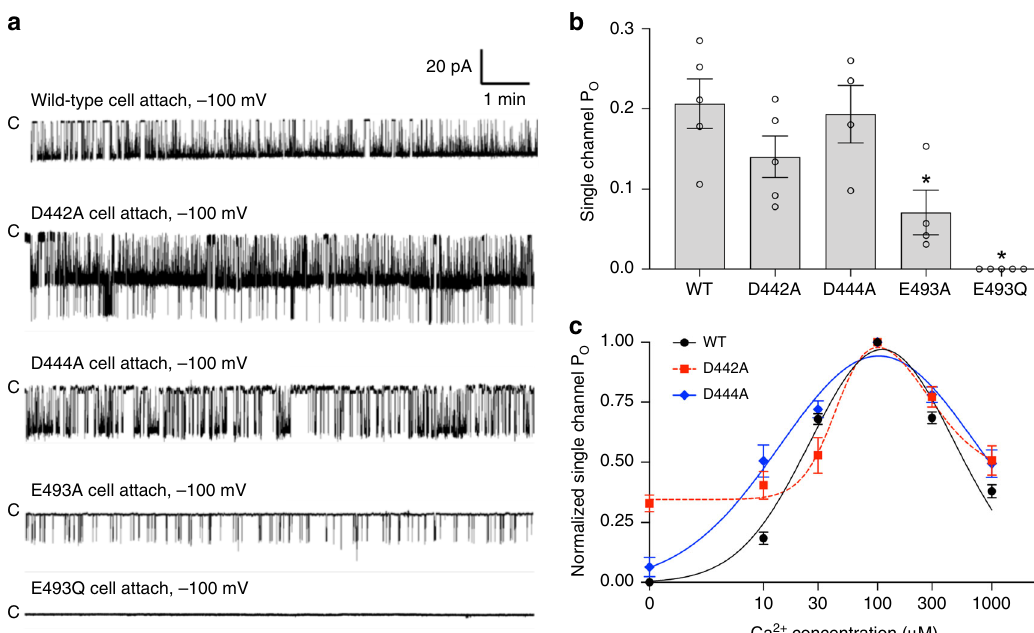
Fig. 8 Single-channel activity of the Ca 2 + site mutants of LjCASTOR-2TM. a Sample traces of single-channel recordings of the Ca 2 + site mutants from cell- attached patches. b Single-channel open probability of the Ca 2 + site mutants of LjCASTOR-2TM; the number above the error bar indicates the number of measurements; *, p < 0.05. c Effect of Ca(I) site mutations on the cytosolic [Ca 2 + ]-dependent activation of LjCASTOR-2TM. The recordings were obtained from the inside-out patches with 150 mM [Na + ] in the pipette solution (extracellular). The bath solution (intracellular) contained 150 mM [K + ] with various [Ca 2 + ]. Data points are mean ± s.e.m. ( n = 5 independent